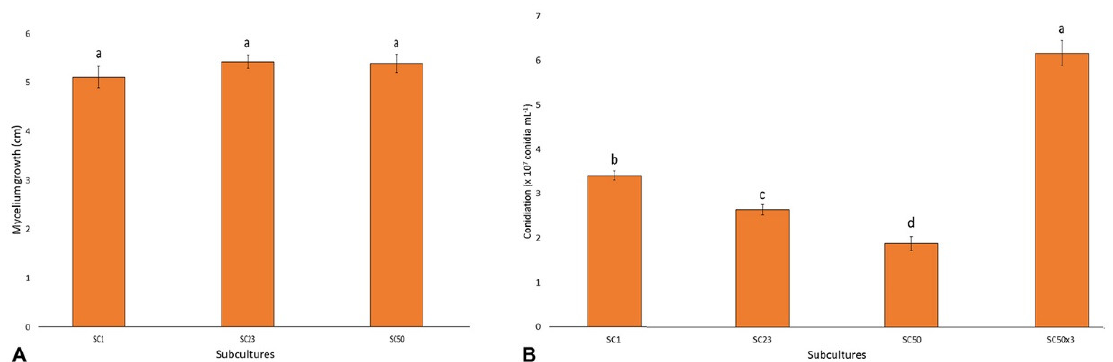
Figure 3. ( A ) Subcultures development (cm) along the diameters of Petri dishes containing PDA. Columns represent the average of three replicates ( ± SE). Values with the same letters are not significantly different ( p > 0.05) based on Duncan’s multiple comparison tests. ( B ) Average conidia production by SC1, SC23, SC50, and SC50 × 3 developed on PDA under near-UV light for 28 days. Columns represent the average of three replicates ( ± SE). Values with different letters are significantly different based on Duncan’s multiple comparison tests ( p < 0.05).